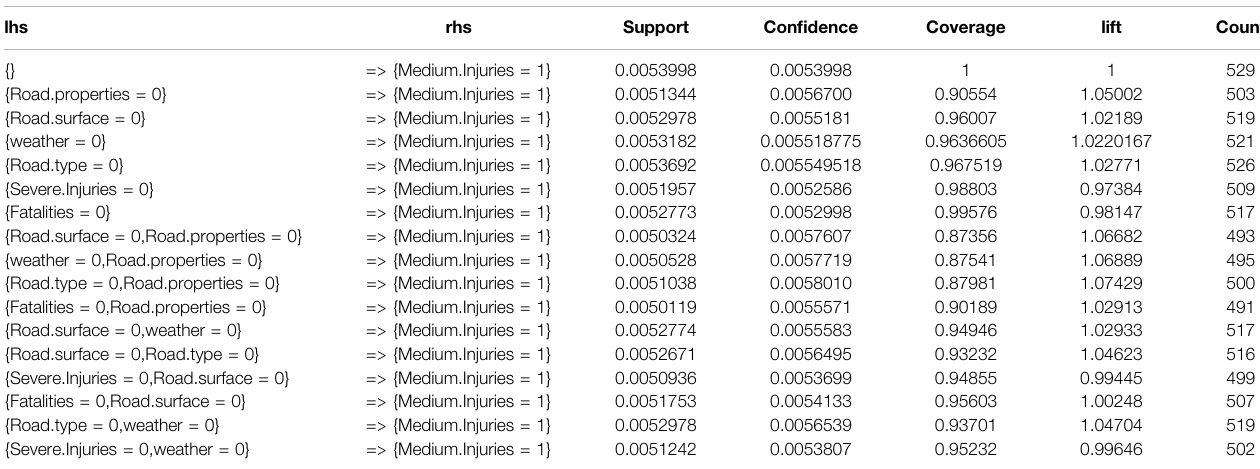
TABLE 5 | Medium injury